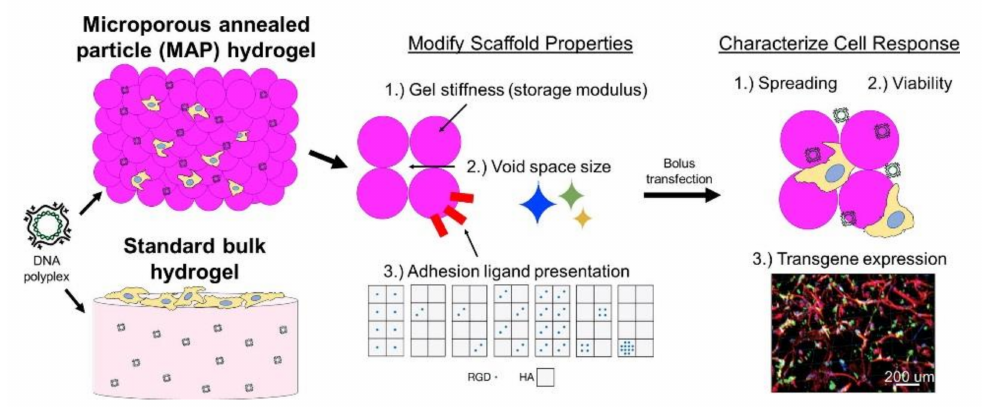
Figure 7. Schematics showing microporous annealed particle (MAP) hydrogels when compared to standard bulk hydrogels. Properties of the MAP hydrogels, including hydrogel stiffness, void space size, and cell adhesion ligand presentation, can be examined to characterize their effects on cellular responses, such as cell spreading and viability as well as transgene expression. Reproduced with permission from [118]. © 2021